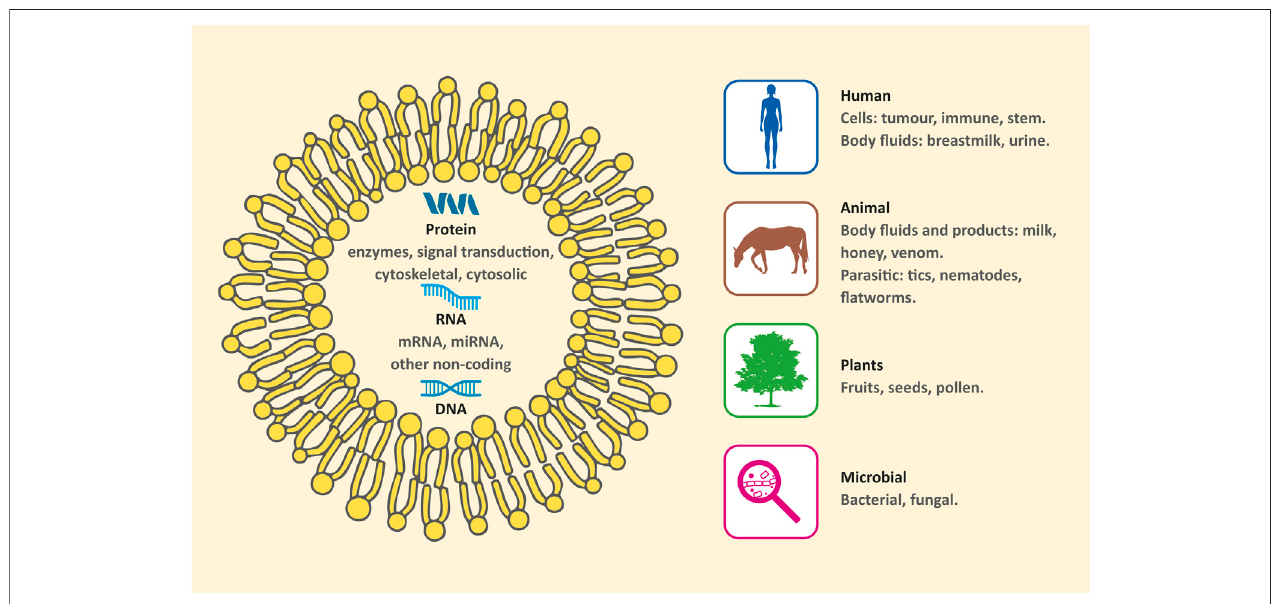
FIGURE 1 | Sources of